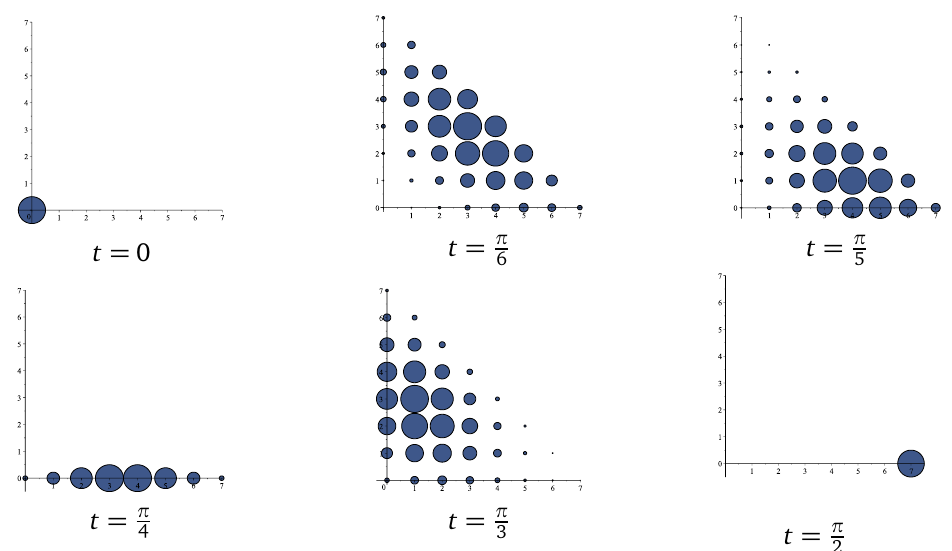
( t ) | for A + 2 A = 7. The areas ( 1,0 ) ( 0,1 ) when N i , j ( t ) | at the given lattice point ( i , j ) . PST occurs i , j ) π 4